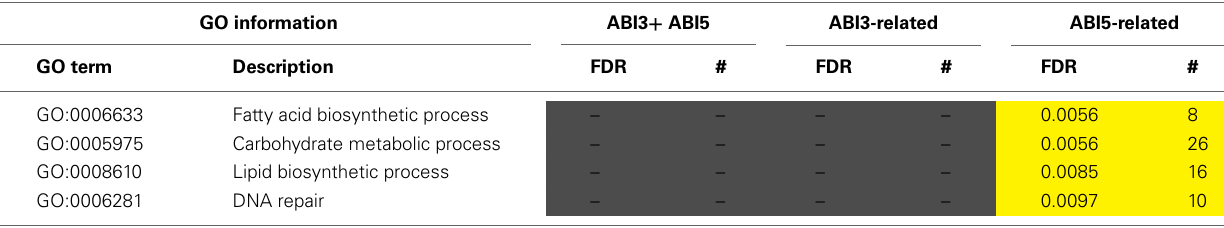
Table S1 | List of transcripts that are differentially expressed in relation to desiccation tolerance (DT-UP and DT-DOWN) list (Figure 1). Table S2 | List of desiccation tolerance (DT) correlated transcripts that are affected by the absence of MtABI5 compared to wild type seeds during the re-induction of DT. Table S3 | List of transcripts that are affected by the absence of MtABI3 compared to wild type seeds during seed maturation at 32 DAP ( Mtabi3 32